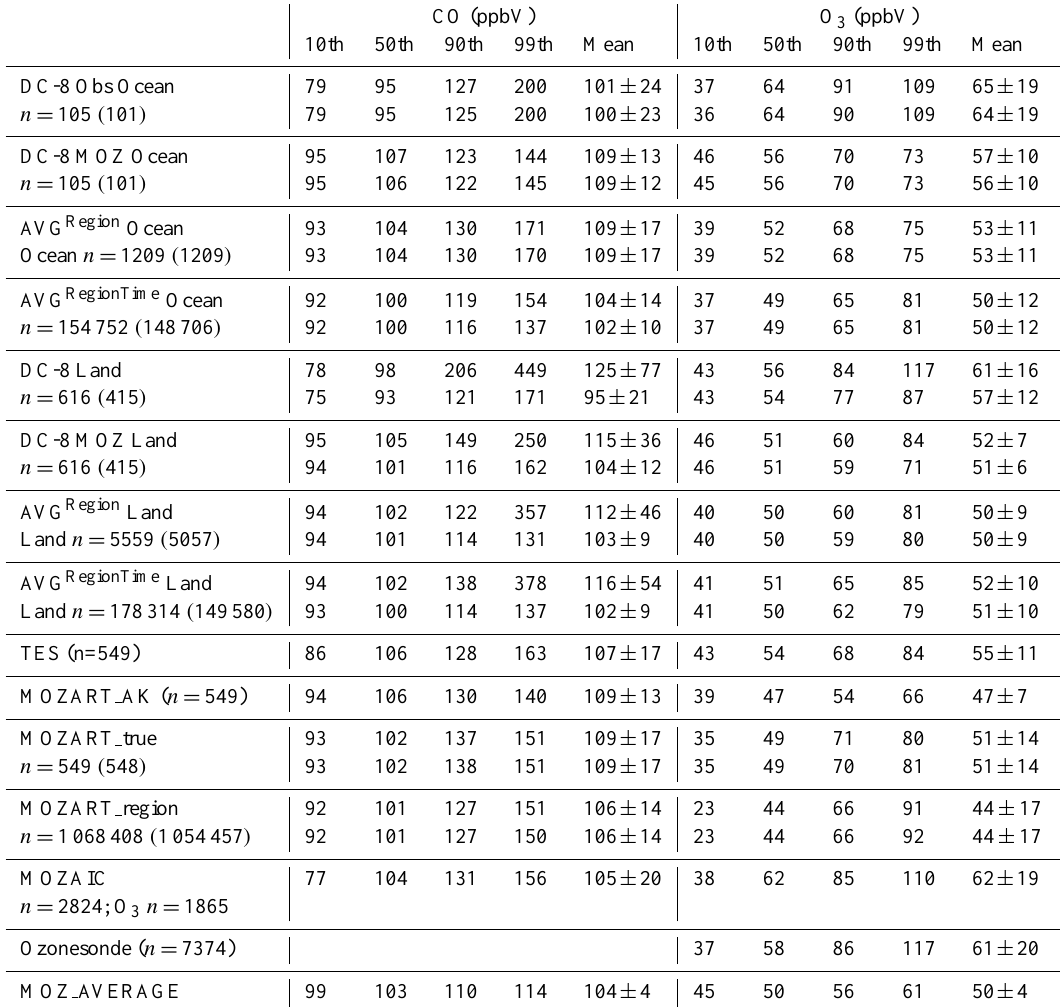
Table 2. Percentiles, mean and standard deviation for different data sets (2–8km or 850–350hPa). The second row, where given, gives results when US fire influenced data are omitted. The numbers in the furthest left column give the number of data points that went into the no-fire impacted statistics if filtering was